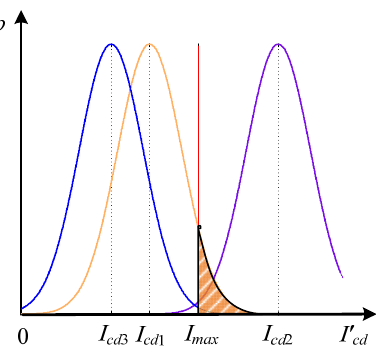
Figure 3. The probability density function of the differential